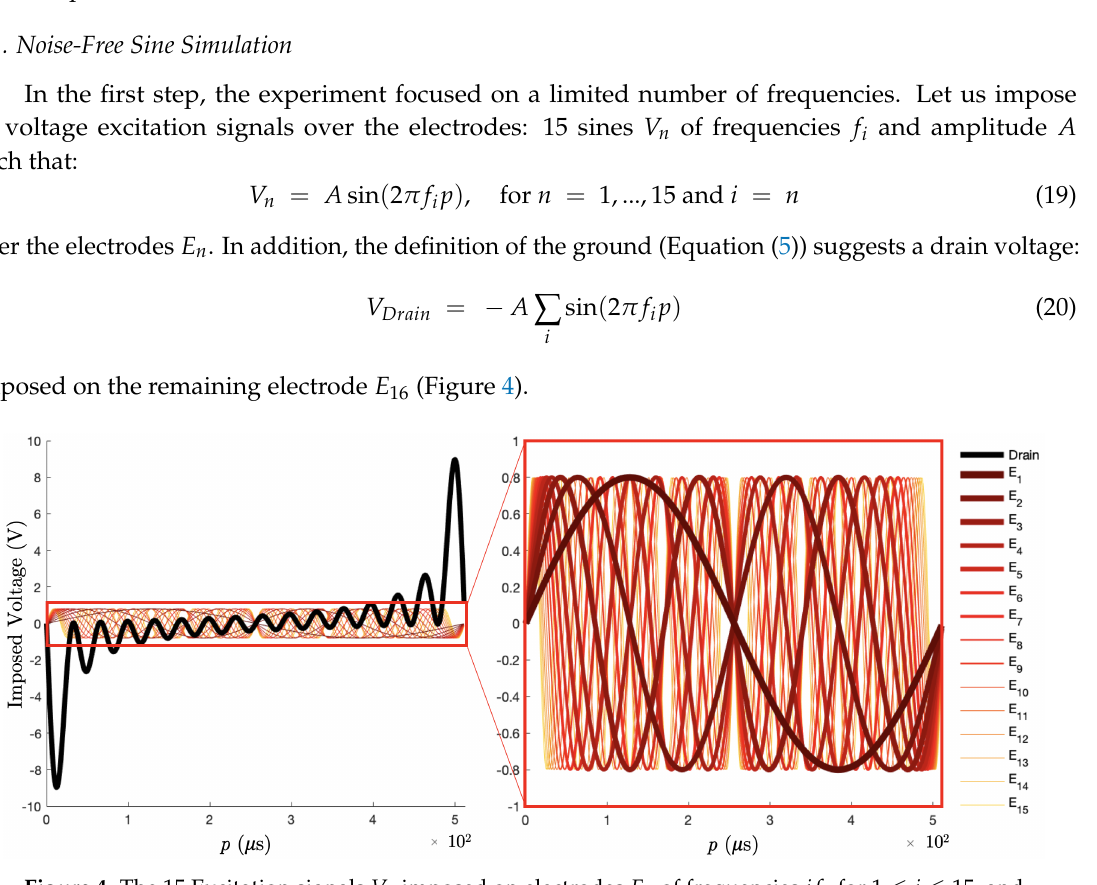
Figure 4. The 15 Excitation signals V n imposed on electrodes E n of frequencies if 1 for 1 ≤ i ≤ 15, and f 1 = ( 512 µ s ) − 1 . The drain excitation signal is shown in black on the left